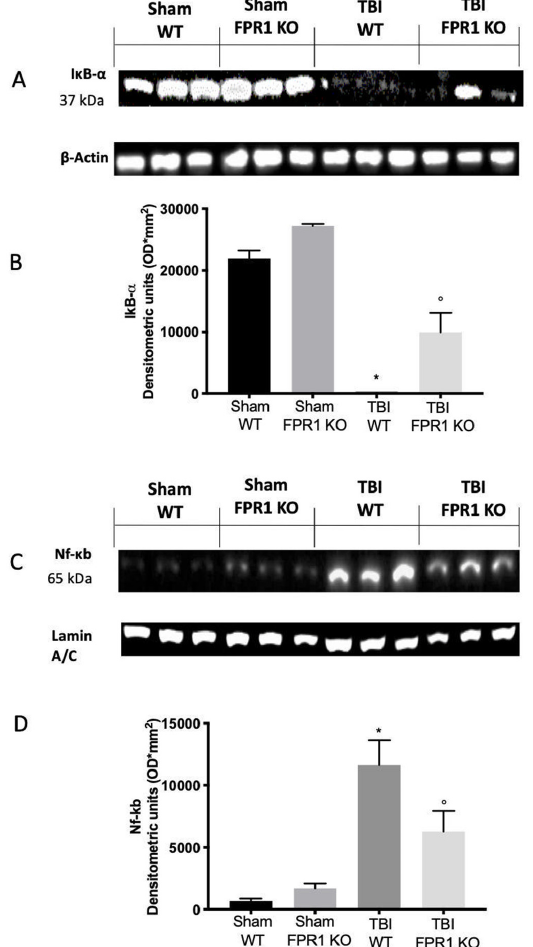
Figure 5. E ff ect of the absence of Fpr1 on IkB- α and NF-kB p65 expression: Western blot analysis shows basal expression of IkB- α in the Sham WT group and Sham Fpr1 KO group ( A ). A significant reduction in IkB- α expression in the TBI WT group 24 h after injury, while TBI Fpr1 KO animals show an increased IkB- α expression; see the densitometric analysis ( B ). Western blot analysis shows an upregulation of Nf-kb expression in the TBI WT group 24 h after TBI injury, compared to the Sham WT and Sham Fpr1 KO group ( C ). Fpr1 KO animals 24 h after TBI show a reduced Nf-kb translocation into the nucleus compare to the TBI WT group; see the densitometric analysis ( D ). For the analyses, n = 5 animals from each group were employed. Results were analyzed by two-way ANOVA followed by a Bonferroni post-hoc test for multiple comparisons. Non-parametric data were analyzed with Fisher’s exact test. * p < 0.05 vs. Sham WT; ◦ p < 0.05 vs. TBI